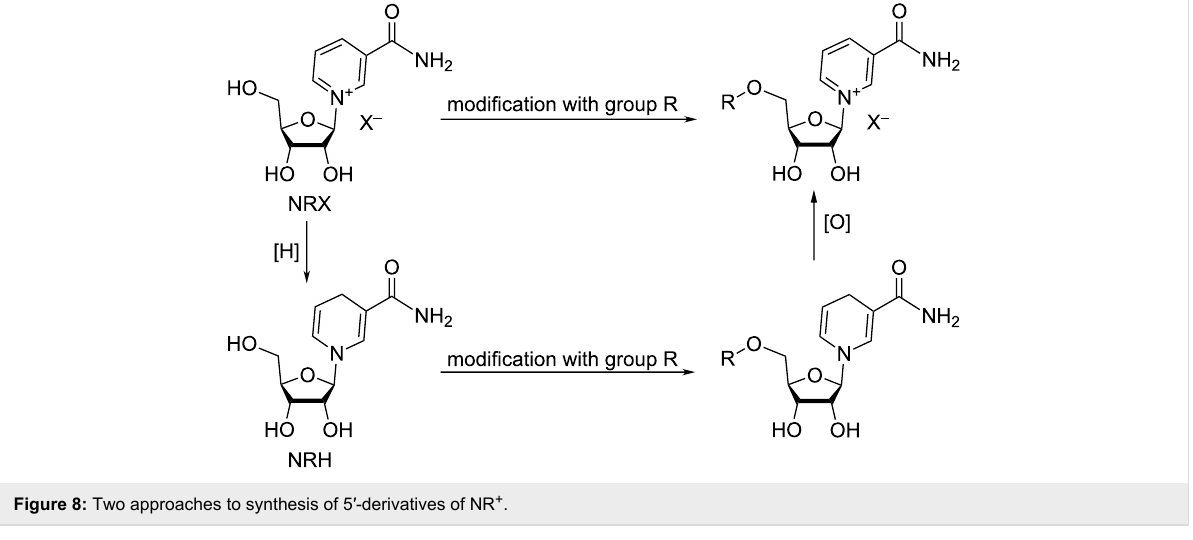
Figure 8: Two approaches to synthesis of 5 ′ -derivatives of NR + .